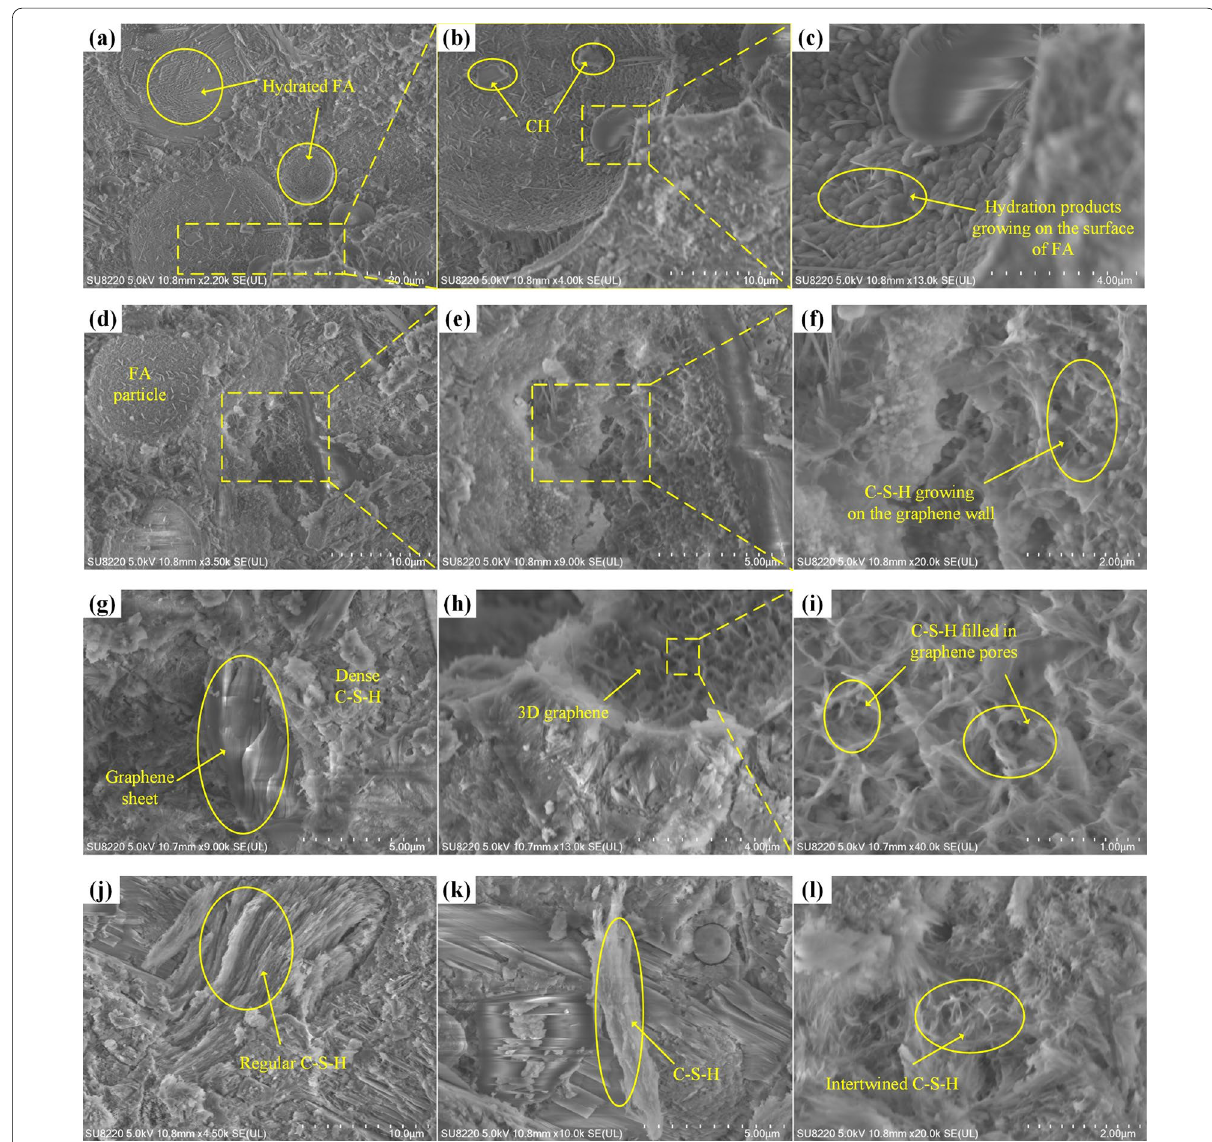
Fig. 7 SEM images of 0.1 wt% 3DG-fly ash cement paste: a – c Reaction degree of fly ash; d – i Combination of 3DG and hydration products; j – l Morphology of